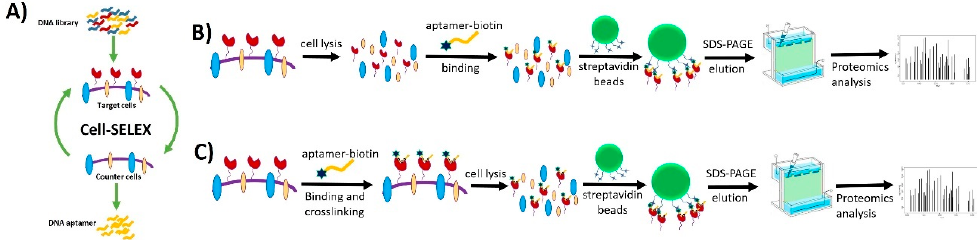
Figure 14. Aptamer-based isolation of target protein biomarkers with crosslinking aptamers and target proteins for cancer cell surface biomarker discovery. ( A ) Cell-SELEX technology selects a panel of aptamers capable of distinguishing molecular differences between two types of cells. ( B ) Aptamer-assisted affinity purification without cross-linking aptamers and target proteins as targets proteomics strategy for cancer cell surface biomarker discovery. ( C ) Aptamer-assisted affinity purification with cross-linking aptamers and target proteins as targeted proteomics strategy for cancer cell surface biomarker discovery. Reprinted with permission from © (2017) American Chemical Society [95].